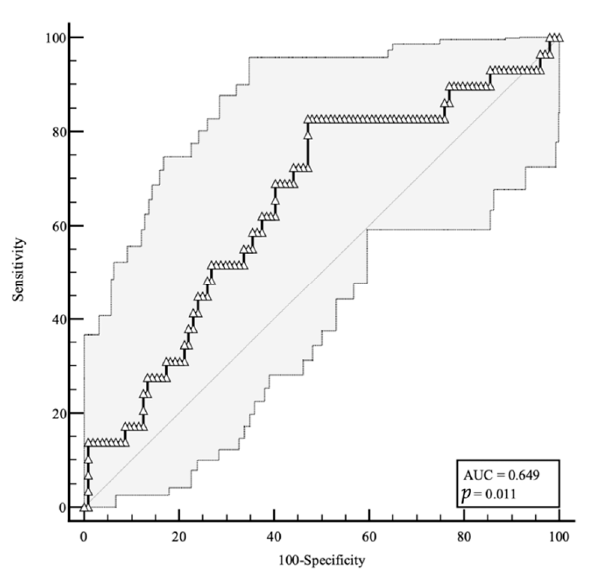
Figure 3. This graphical plot illustrates ROC curve for plasma OPN levels at the time of hospital admission predicting a severe disease evolution. As shown in figure, higher OPN values are predictive of a negative disease evolution. AUC, area under the curve; p , p -value.